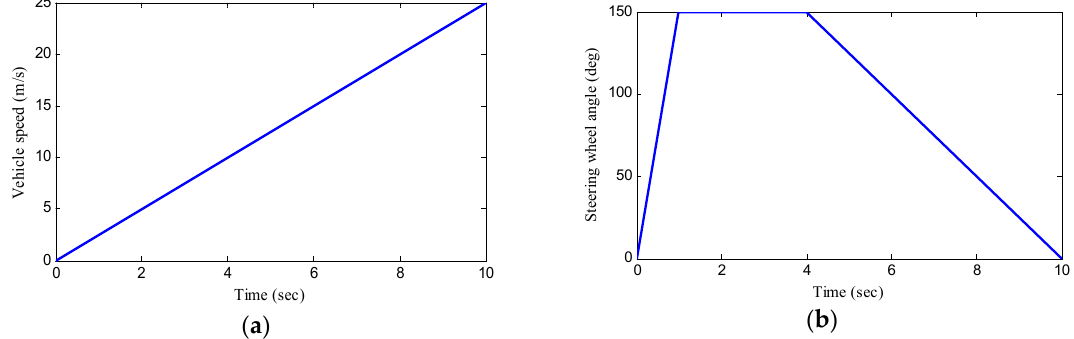
Figure 13. Simulation condition in case study 2. ( a ) Planned vehicle speed; ( b ) Steering wheel angle. World Electric Vehicle Journal 2019 , 10 , 15